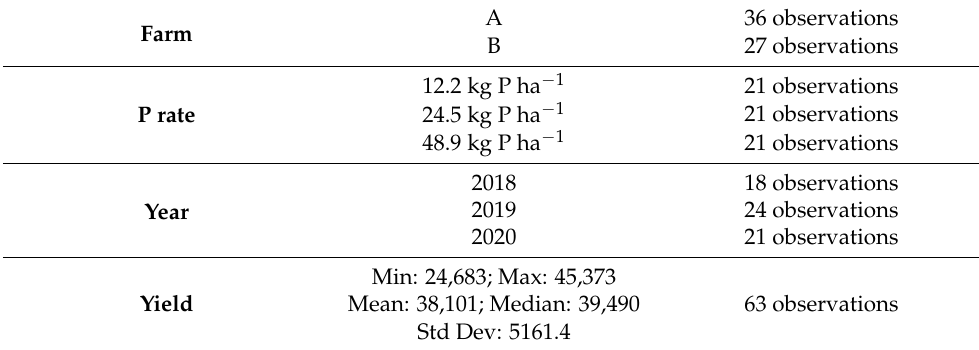
Table 4. Descriptive statistics of yield, P rate, year, and farm.